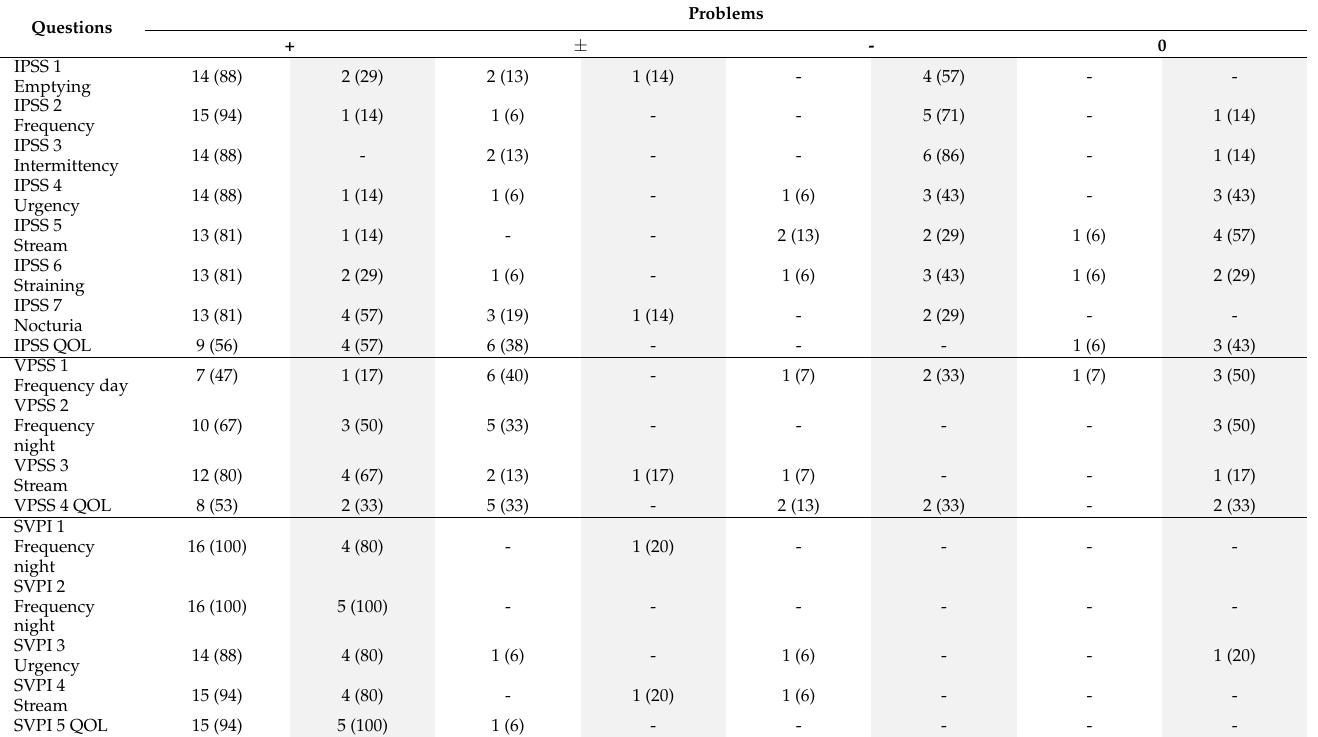
Table A2. Overview of problems while filling out a LUTS